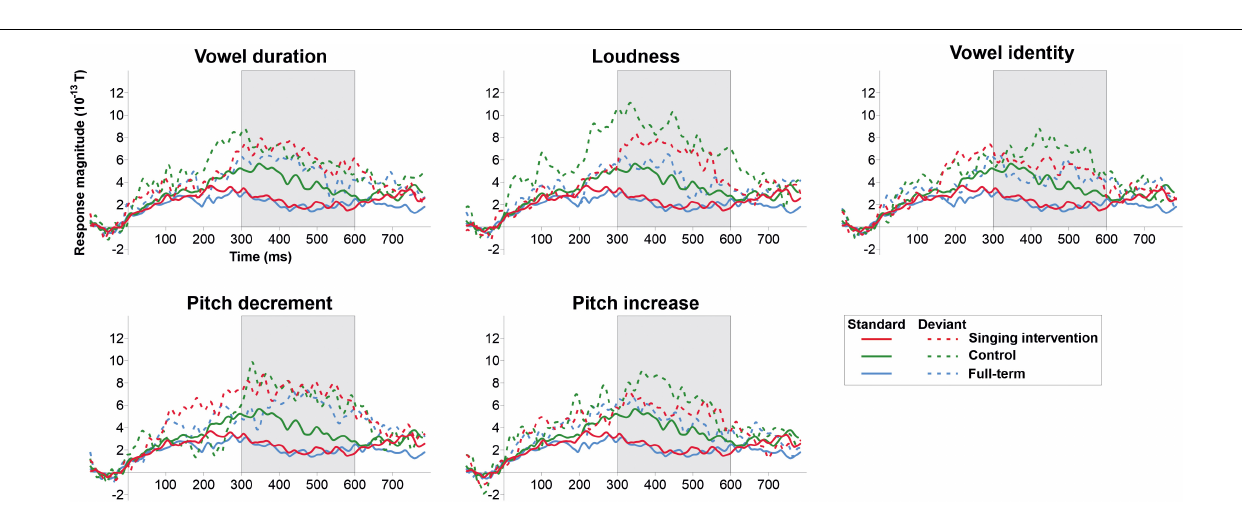
FIGURE 2 | ERP responses to the standard tata (solid lines) and responses to all deviant types (dashed lines) for all the groups in the tata paradigm. Grayed area denotes the predefined MMR time